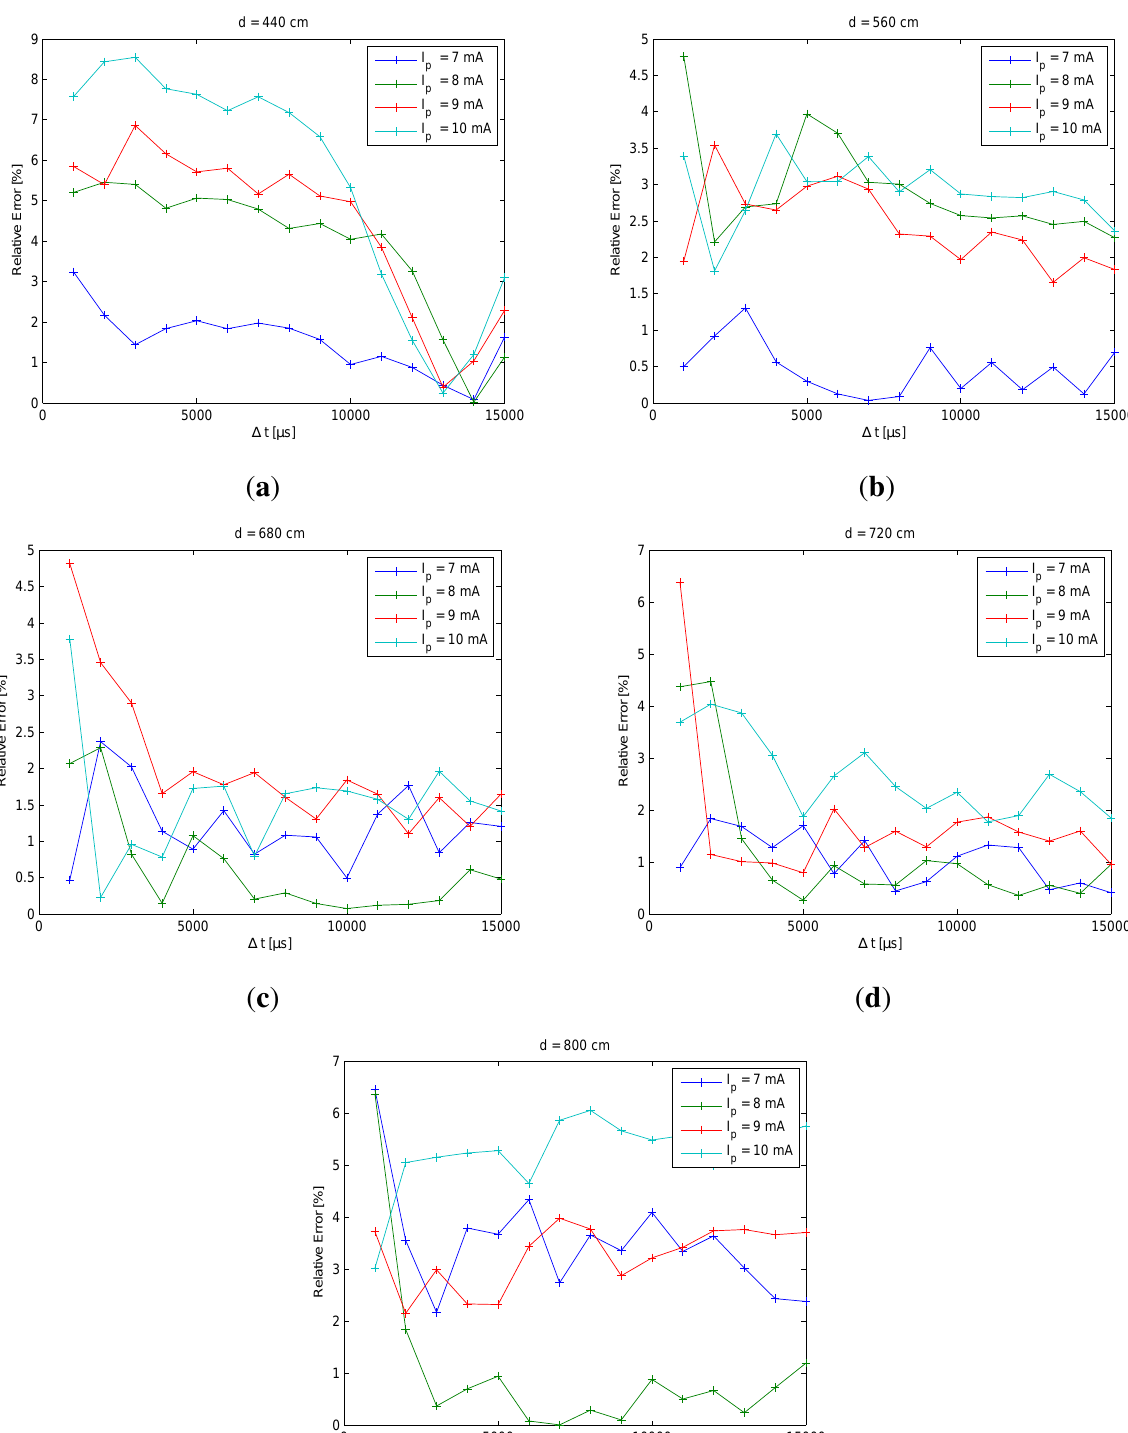
Figure 10. Relative error in the calibration process as a function of exposure time differences. In these figures different distances were considered: (a) 440 cm, (b) 560 cm, (c) 680 cm, (d) 720 cm and (e) 800 cm. From the performance of the calibration process it is possible to obtain the optimum exposure time differences to carry out the distance measurement process. Optimum △ t to carry out the measurement process coincides with △ t where lowest error was obtained in the calibration